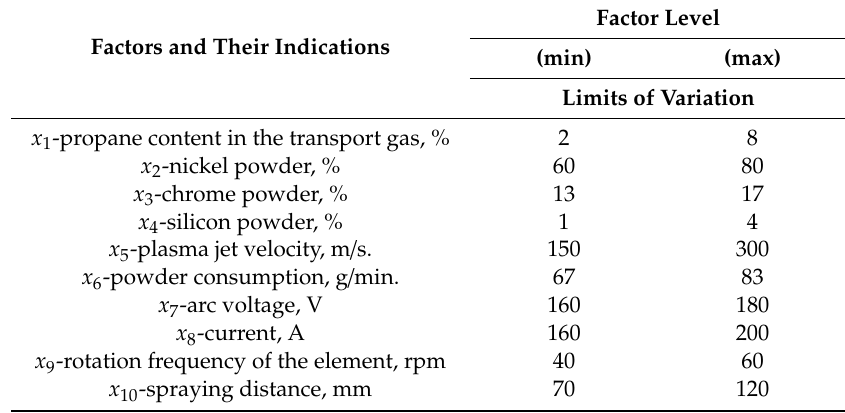
Table 1. Factors A ff ecting the Plasma Spraying